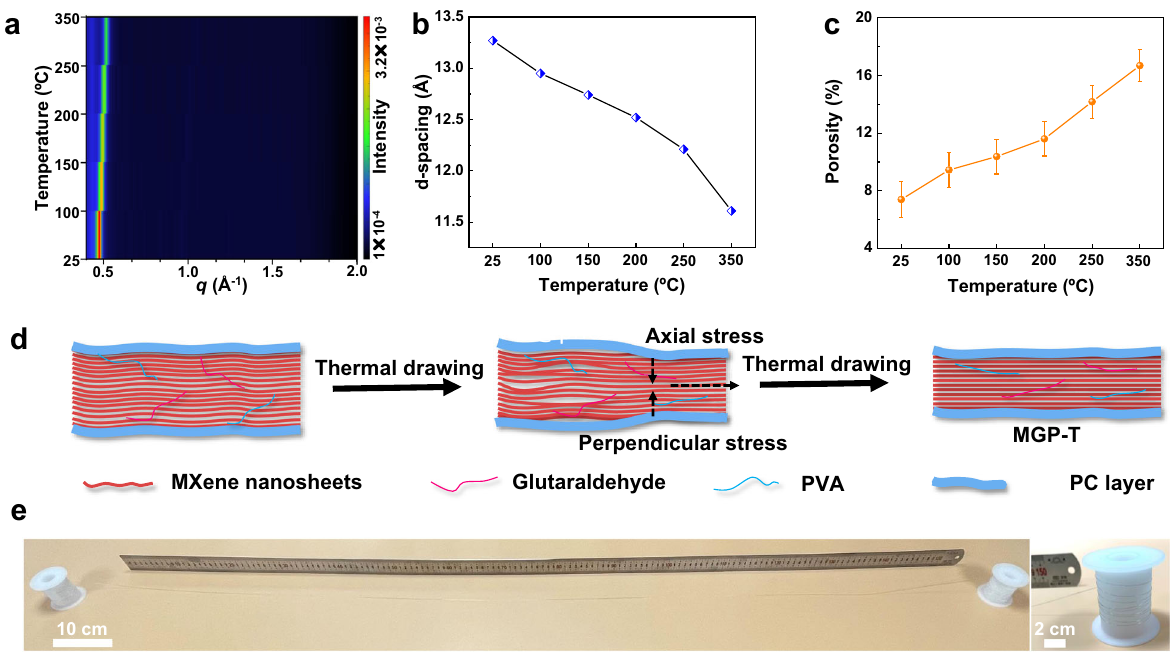
Fig. 3 | In-situ XRD patterns and fabrication of MGP-T fi bers by thermal drawing. a In-situ XRD patterns graph of MGP fi ber. b Curve of d-spacing vs. temperatureaccordingtoin-situXRDpatterns. c PorosityofMGP fi berswhenbeing